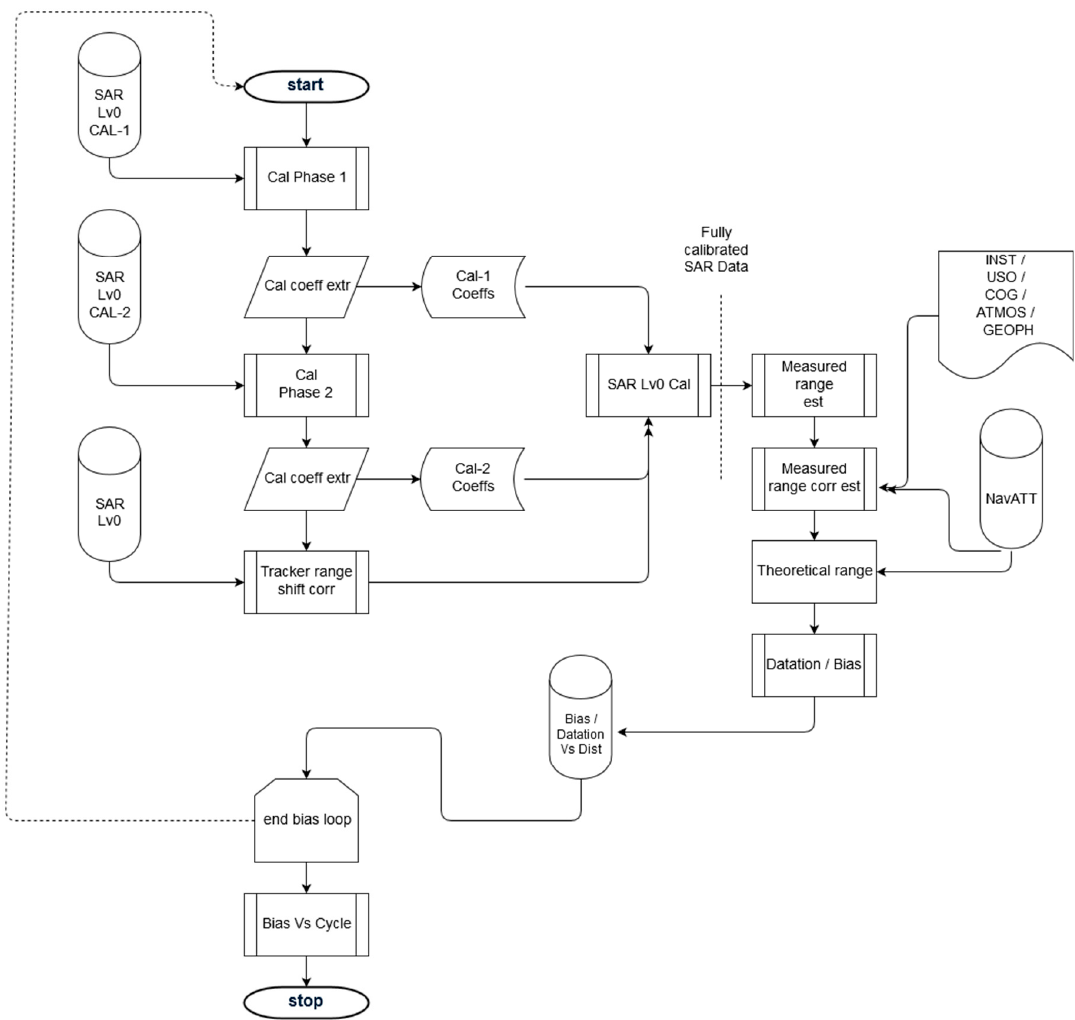
Figure 7. Flowchart of the transponder calibration developed for range and datation bias estimation of Sentinel-3A.